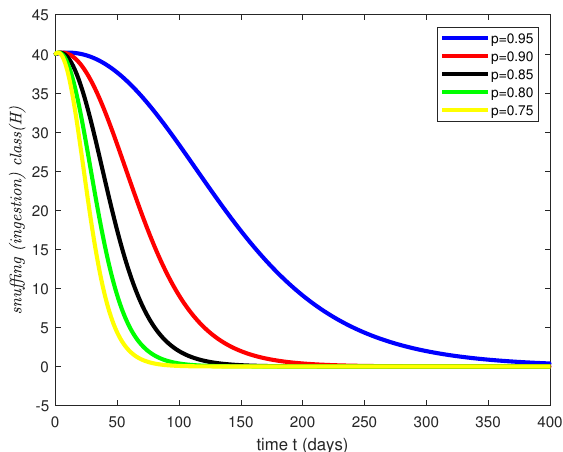
Figure 2. Adaptive nature of the approximated result for the snuffing class H ( t ) class of the proposed model at different arbitrary fractional orders.